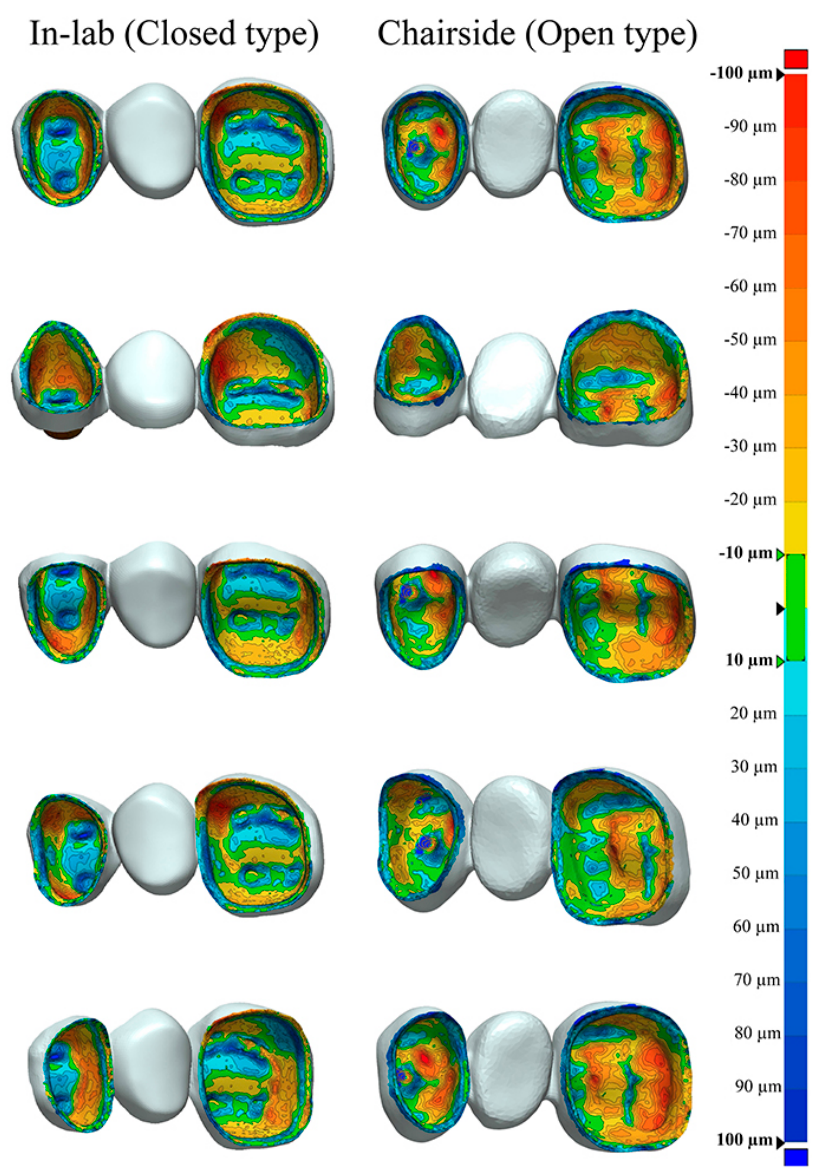
Figure 8. Comparison of the color di ff erence map of trueness by digital workflows. The results of the correlation between the trueness of the milling unit and the fitness are shown in Figure 9. The trueness and internal fit showed a positive correlation (correlation coe ffi cient = 0.621) only in the in-lab (open type) group ( p = 0.013). There was no significant correlation between the trueness and marginal fit in the in-lab (open type) group ( p = 0.070). There was no significant